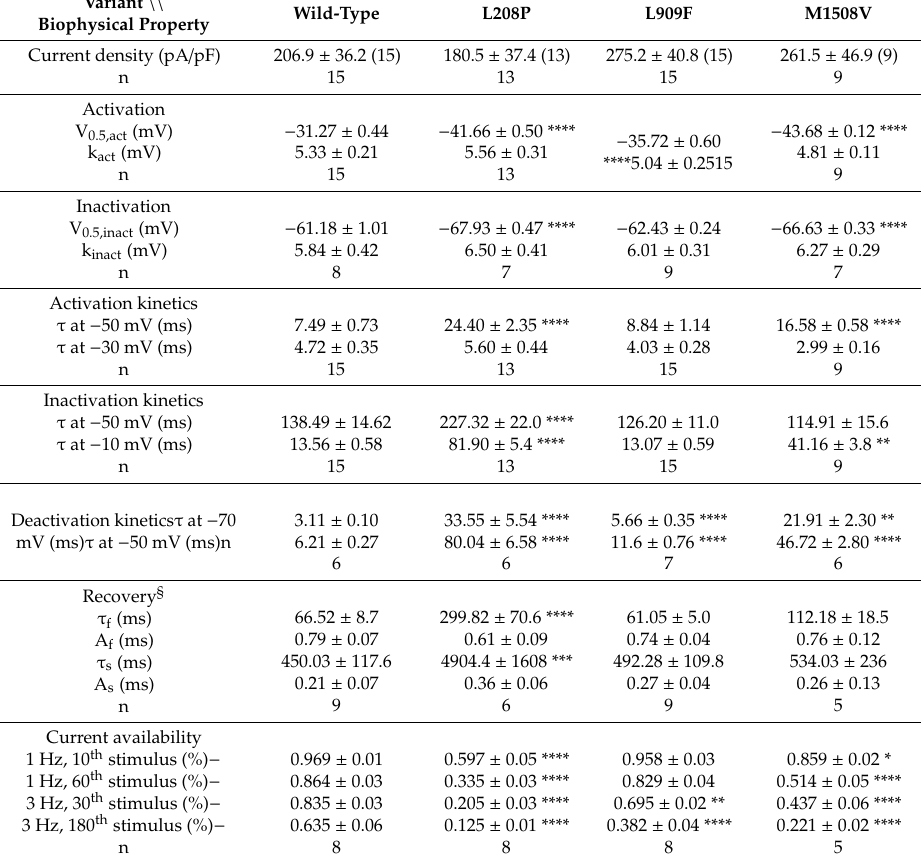
Table 1. Biophysical parameters of Ca v 3.1 channel variants expressed in HEK-293T